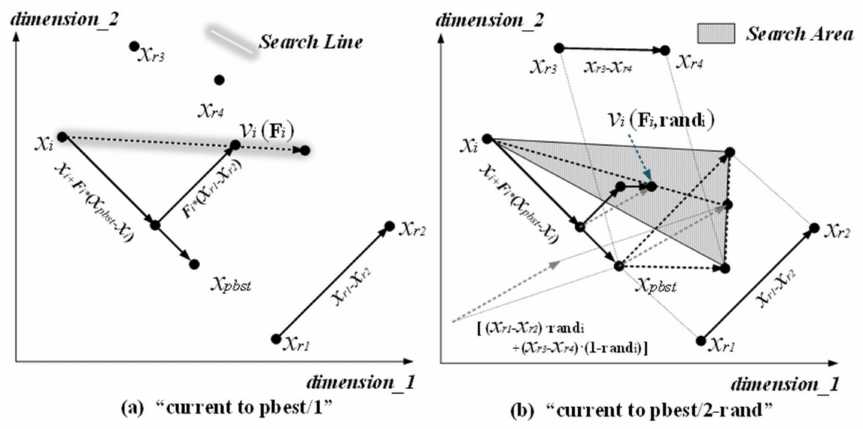
Figure 2. Illustration of the DE mutation strategy in two dimensions.